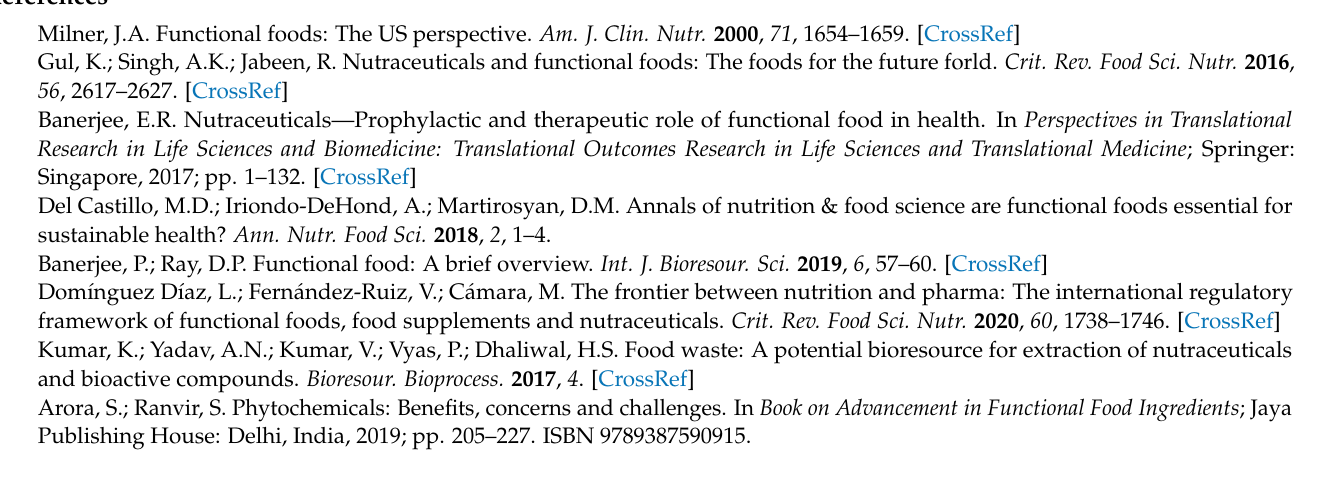
Figure S3a. Effect of the foliar application of the botanical extracts on the total phenolic compounds of outer leaves after the second spraying ( n = 4). Figure S3b. Effect of the foliar application of the botanical extracts on the total phenolic compounds of white head cabbage ( n = 4). Table S2a. Effect of the foliar application of the botanical extracts on the macroelements content of white head cabbage ( n = 3, mean ± SD). Table S2b. Effect of the foliar application of the botanical extracts on the microelements and toxic elements content of white head cabbage ( n = 3, mean ± SD). Table S3. Effect of the foliar application of the botanical extracts on the volatile compounds profile (the amount of a single component calculated as a percentage (%) of the whole GC-MS chromatogram area) of white head cabbage ( n = 3, mean ± SD). Table S4. Effect of the foliar application of the botanical